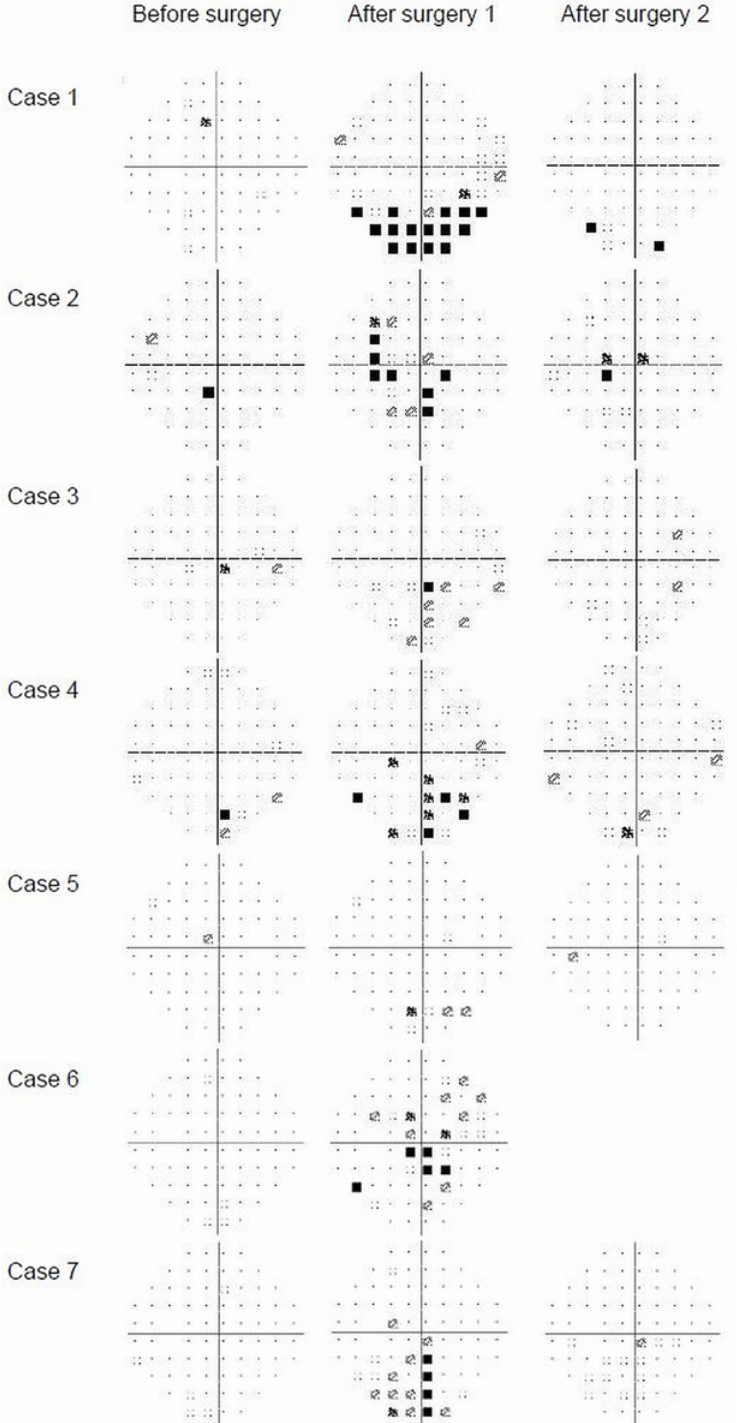
Fig 1. Visual fields of seven eyes of seven cases with unilateral postoperative visual field defects. Before surgery: 0 – 2 months before surgery. After surgery 1: mean of 7.0 days after surgery. After surgery 2: mean of 77 days after